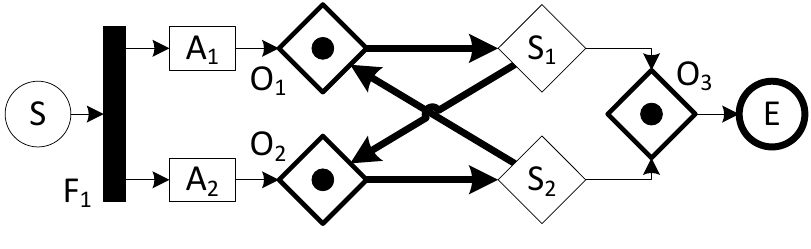
Figure 8. A workflow graph with two OR-joins mutually waiting for each